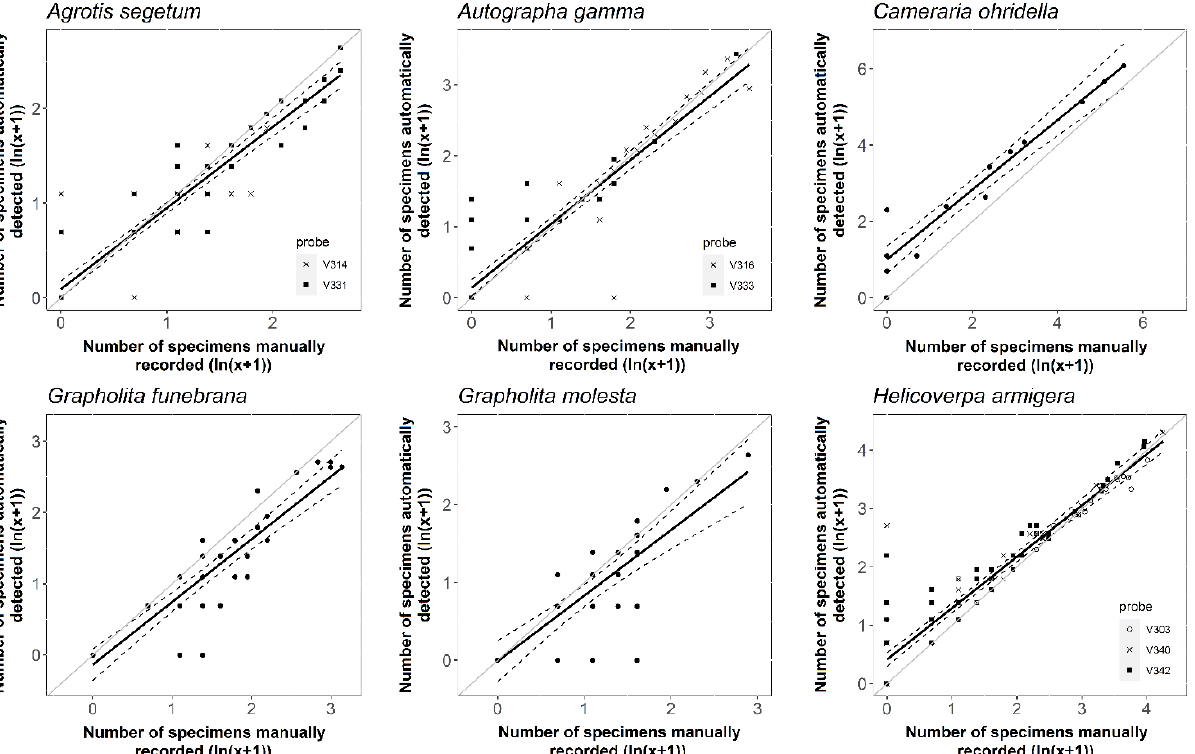
Figure 3. The relationship between the number of detected and captured individuals for six different Lepidopteran species. The solid lines show the predicted values from the linear model, and the dashed lines show a 95% prediction interval. The solid grey lines indicate the equality between the two variables.